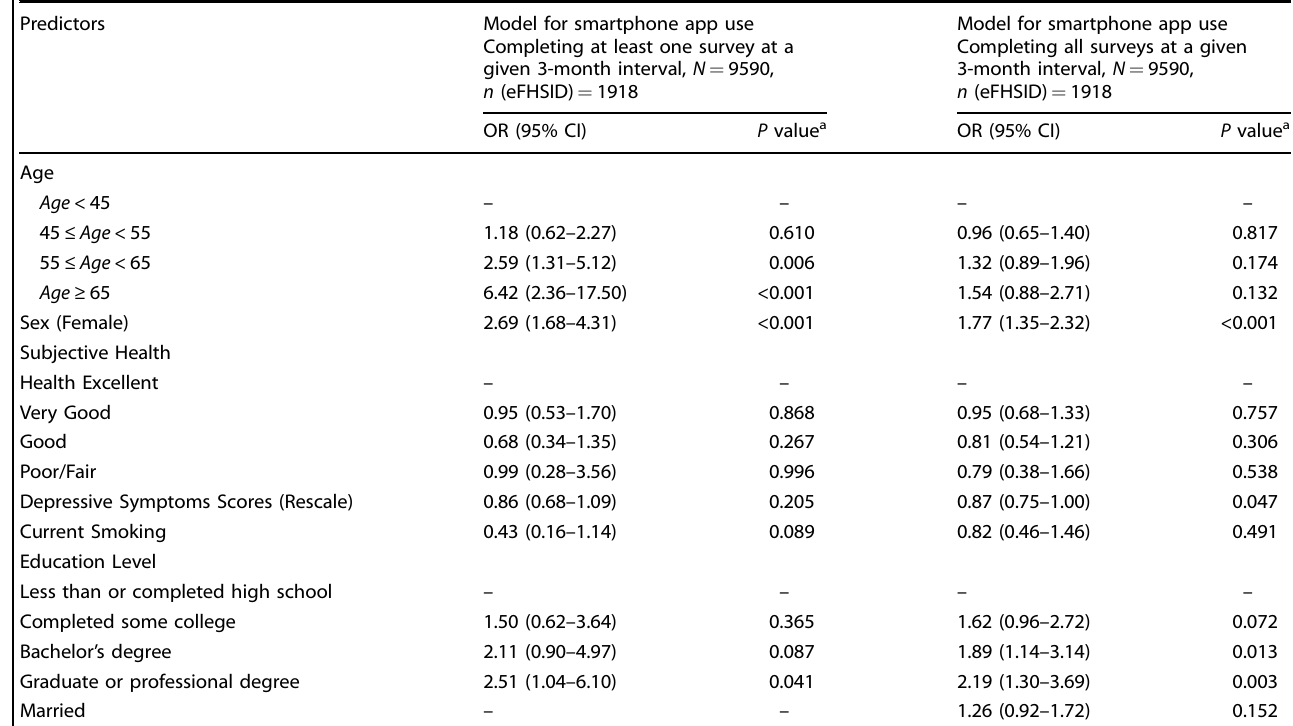
Table 2. Factors associated with smartphone app use: Results of multivariable models.